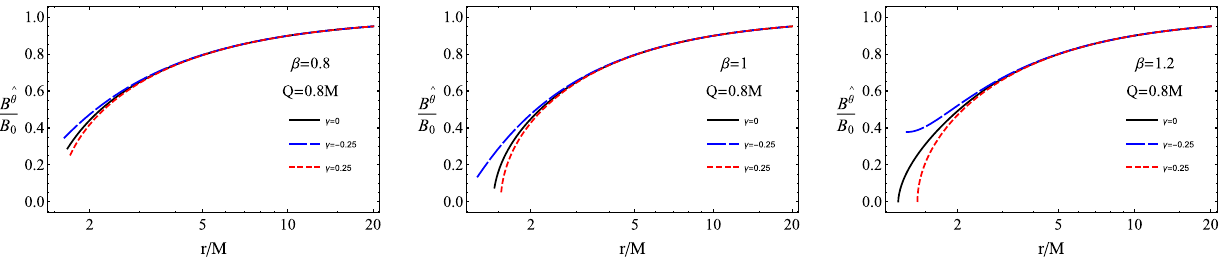
Fig. 5 Orthonormal angular component of the magnetic field around EMS BHs for different values of the parameters γ and β . Here we fixed the BH charge as Q / M = 0 . 8